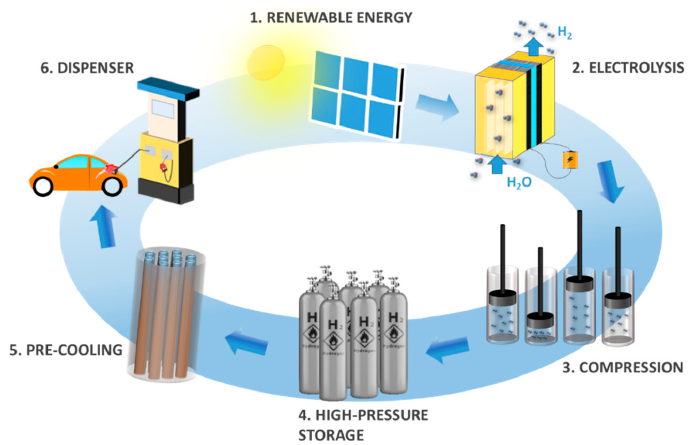
Figure 5. Scheme of hydrogen refueling stations driven by renewable sources.